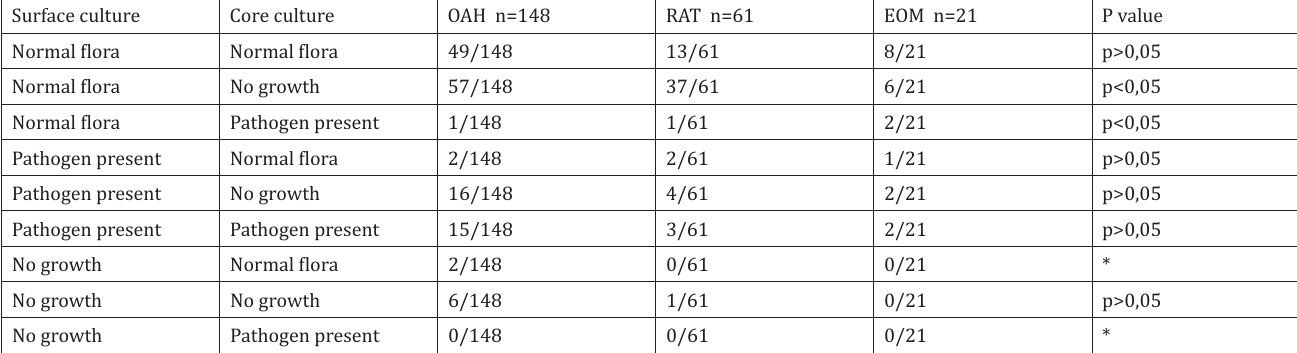
Comparison of surface and core cultures of adenoids in all three groups.